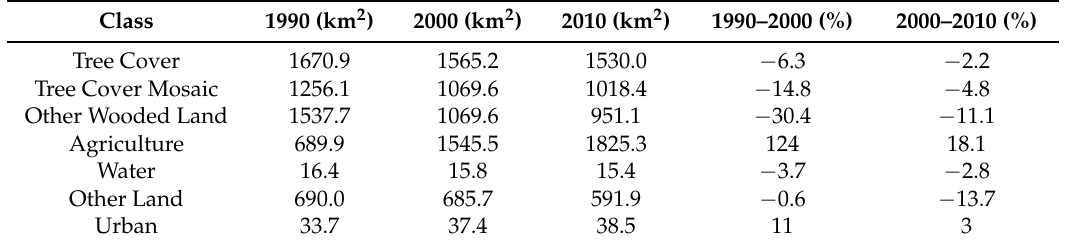
Table 4. LULC in the buffer around UMNP. km 2 and % of variation between 1990–2000 and 2000–2010.